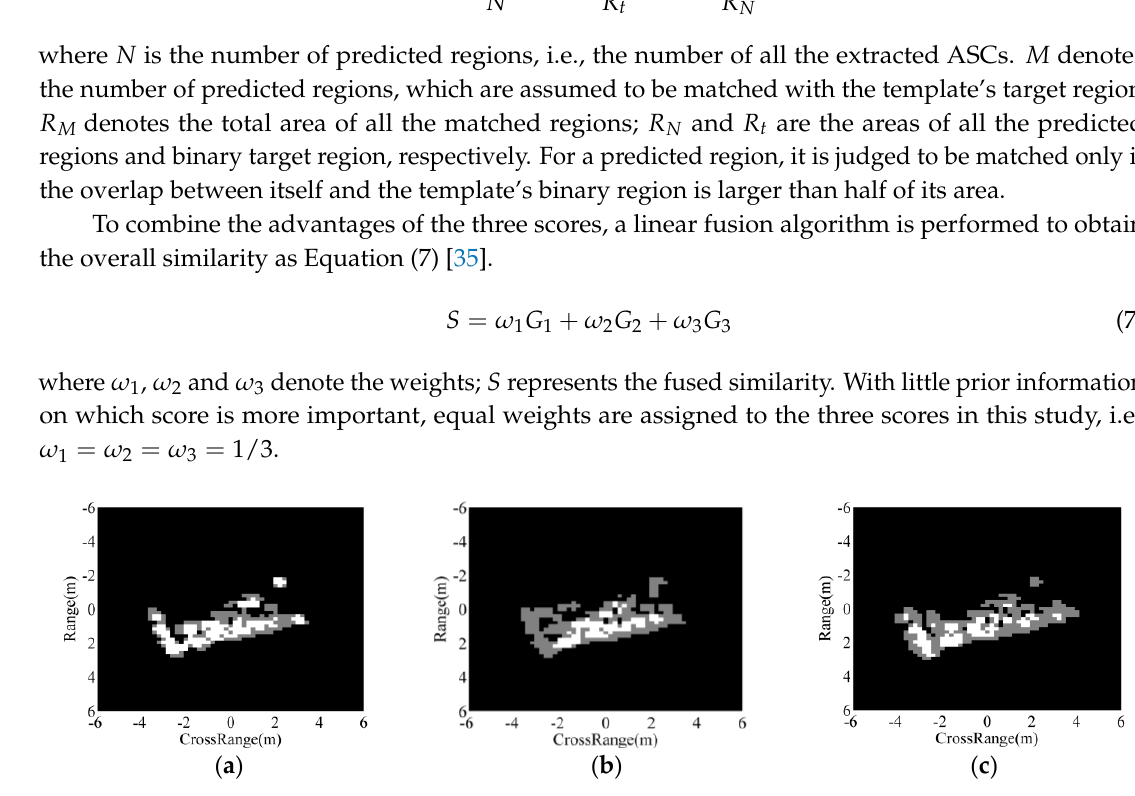
Figure 6. Region matching results between a BMP2 image and three template classes being: ( a ) BMP2; ( b ) T72; ( c ) BTR70.